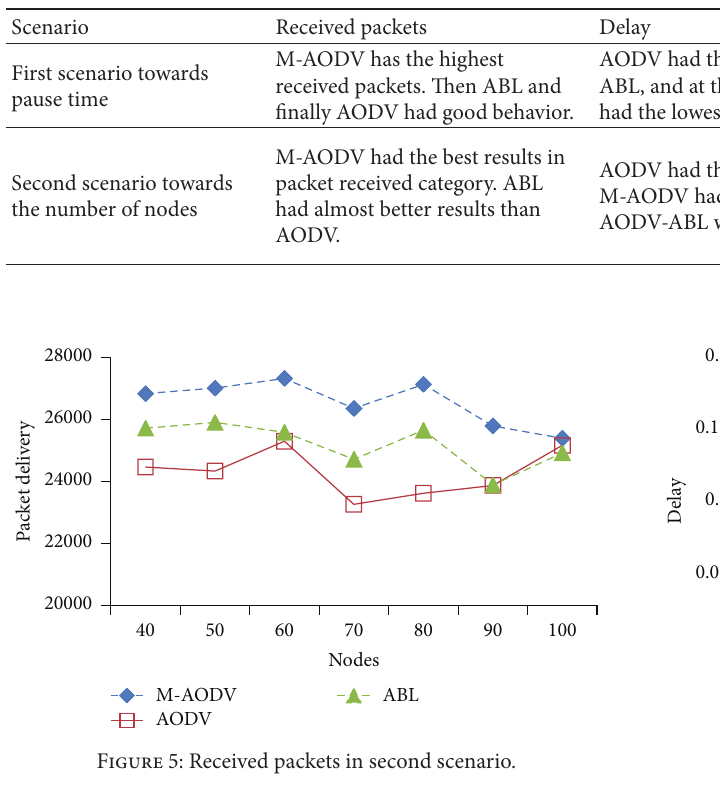
Figure 6: End-to-end delay in second